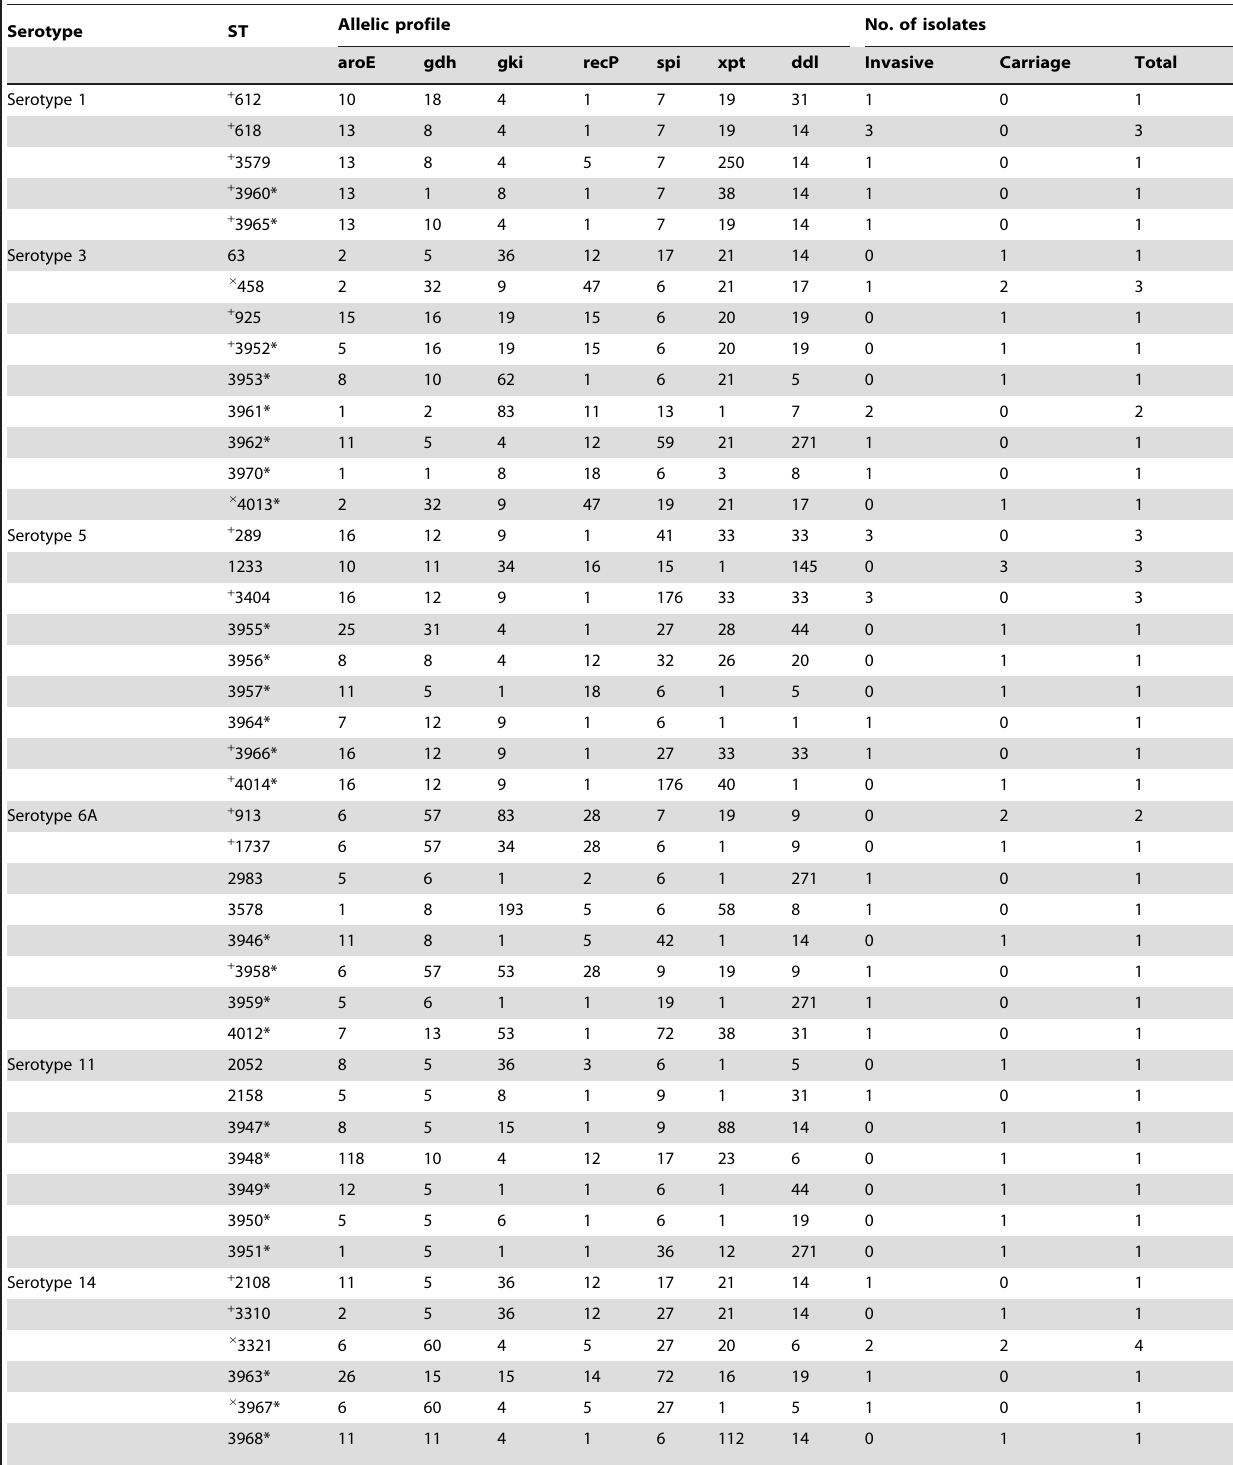
Table 2. MLST of S. pneumoniae isolates of different serotypes.